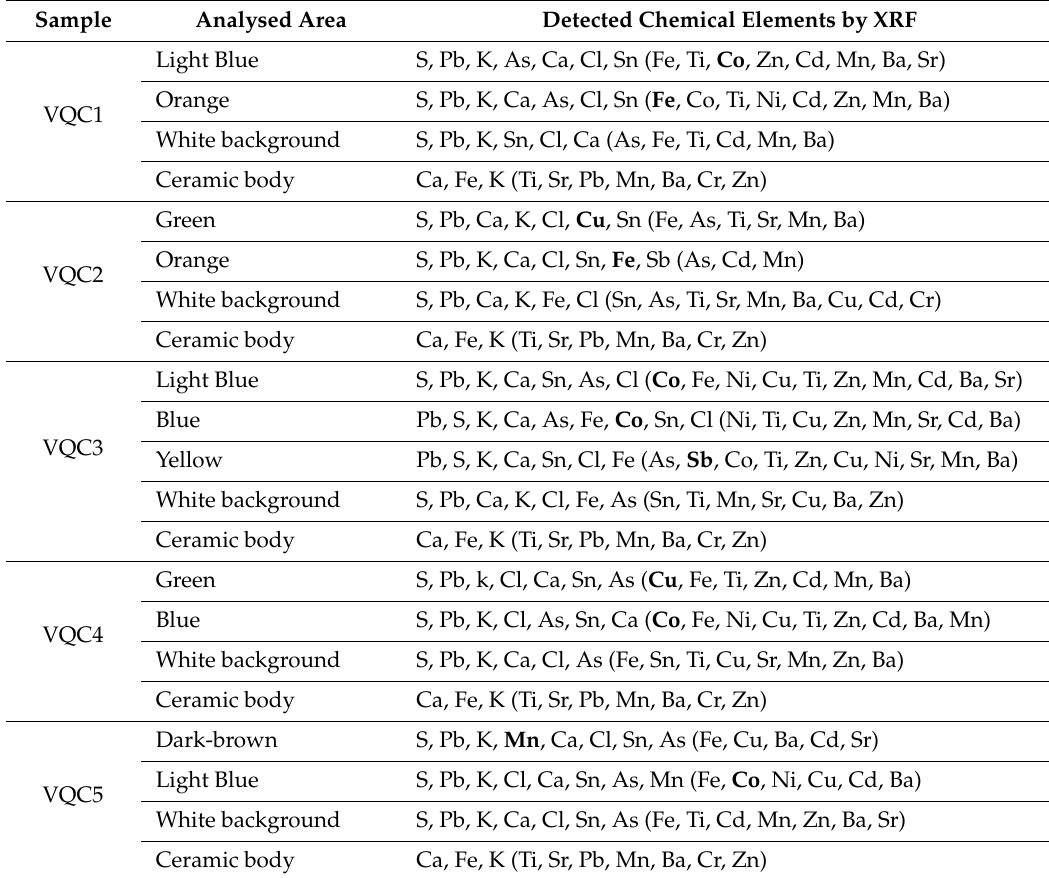
Table 3. Elements detected by X-Ray fluorescence (XRF) analysis. For each sample, the key element for pigment identification is marked in bold. The minor or trace elements are presented between